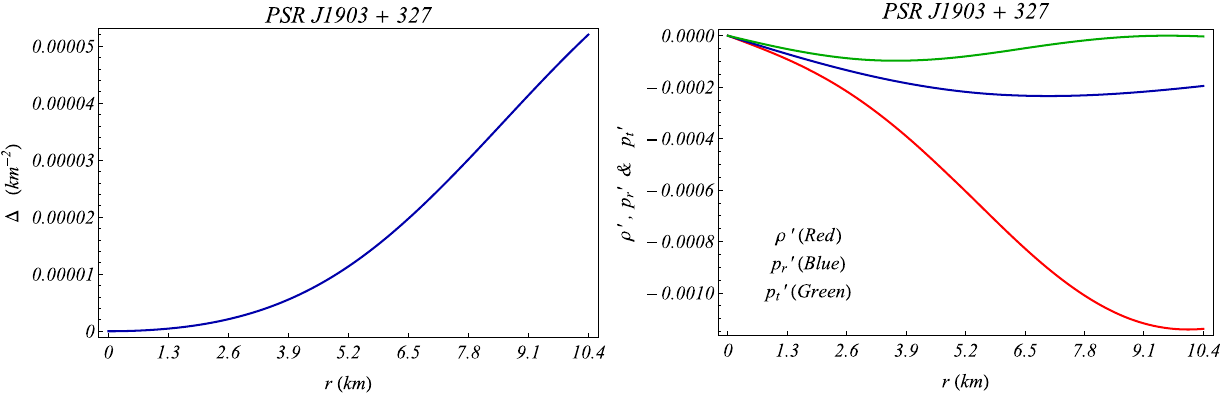
Fig. 3 (Left) The anisotropic factor (cid:3) and (right) the density and pressure gradients are plotted against r inside the stellar interior for the compact star PSR